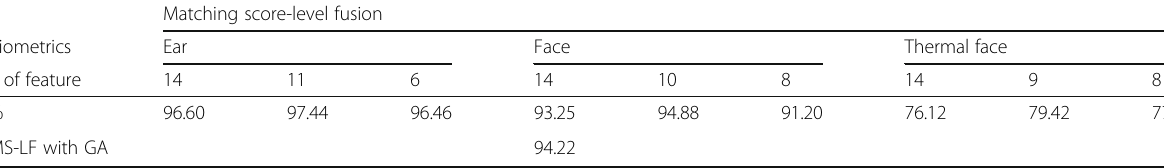
Table 8 Matching score-level fusion with